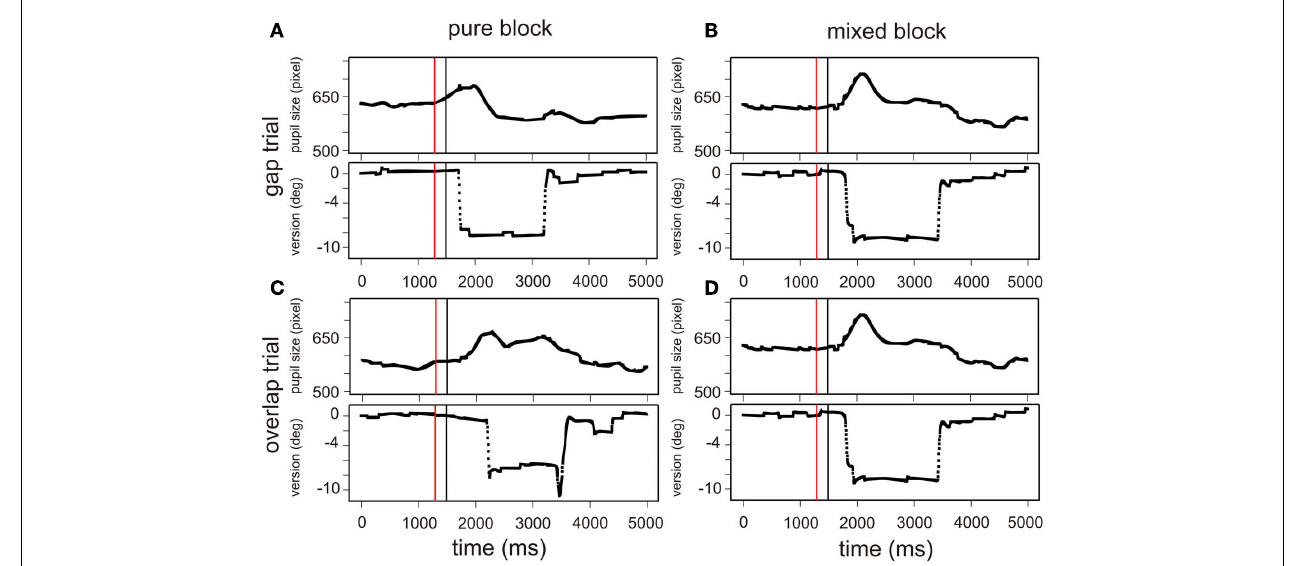
period – target presentation – fixation at target destination – presentation of central target and central fixation.”The red line marks the beginning and the black line marks the end of the period [ − 200 0], for which we analyzed the pupil dilation (for a detailed view on the period [ − 200 0] see Figure 2 ). Accordingly, the black line marks the presentation of the saccade